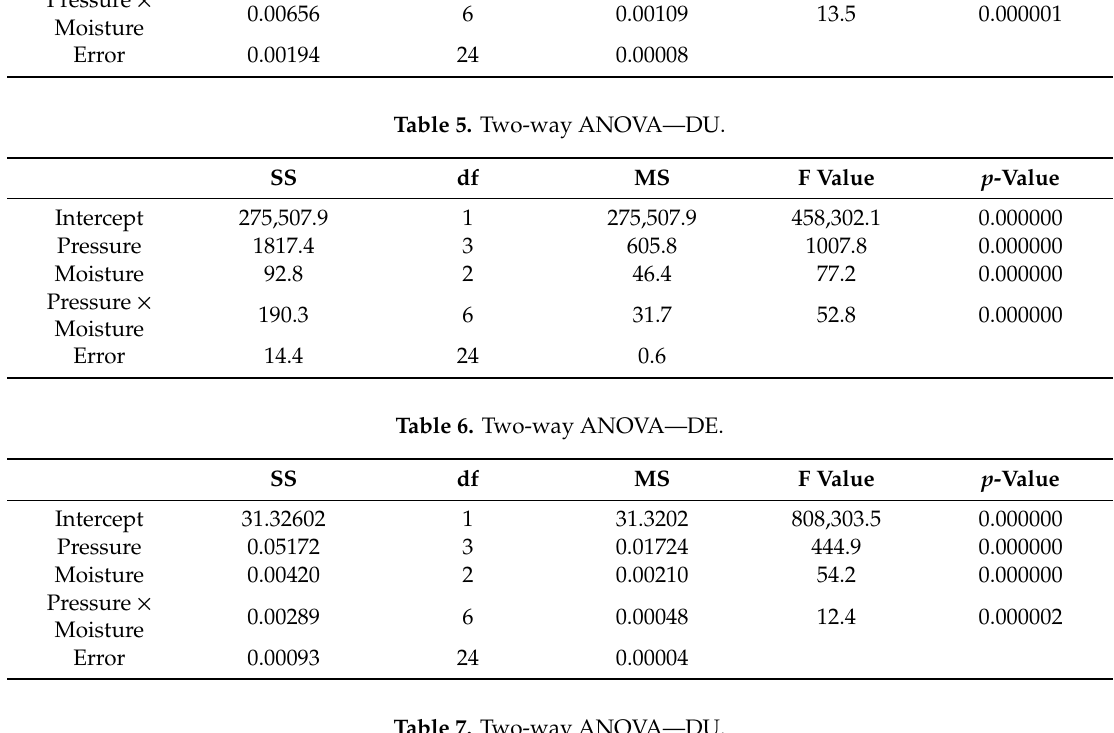
Table 7. Two-way